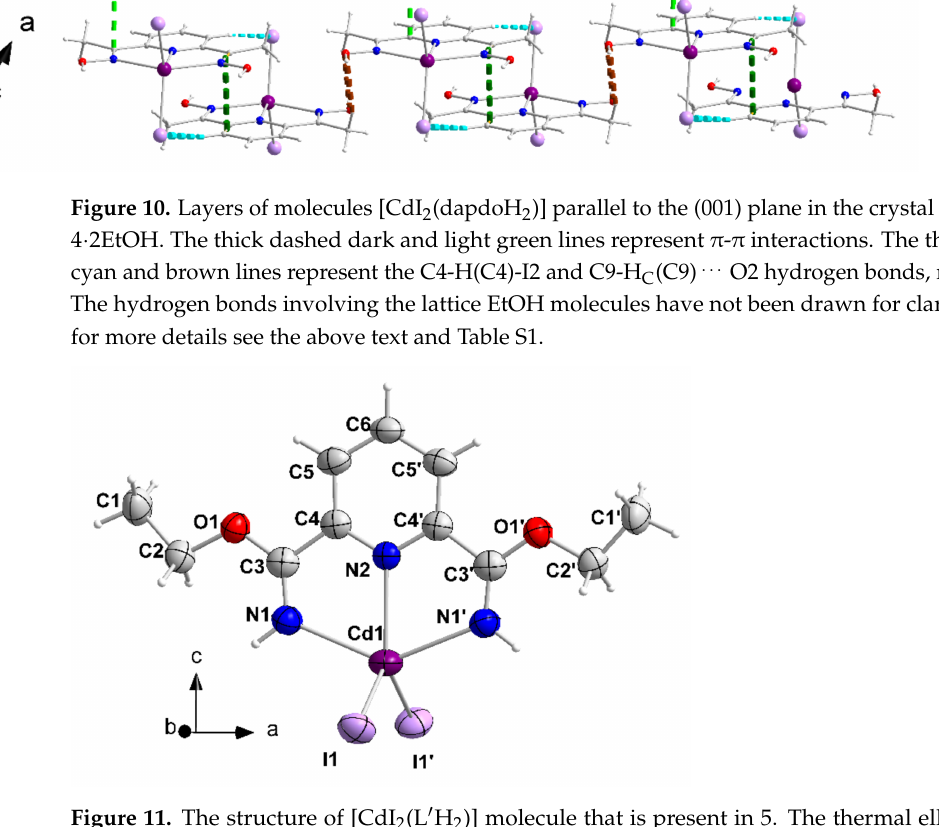
Figure 11. The structure of [CdI 2 (L (cid:48) H 2 )] molecule that is present in 5. The thermal ellipsoids are presented at the 50% probability level. Symmetry operation: ( (cid:48) ) = − x , − y + 3/2, z . Table 2. Selected bond lengths (Å) and angles ( ◦ ) for the complex [CdI 2 (2paoH) 2 ] ( 1 ) a . Bond Lengths